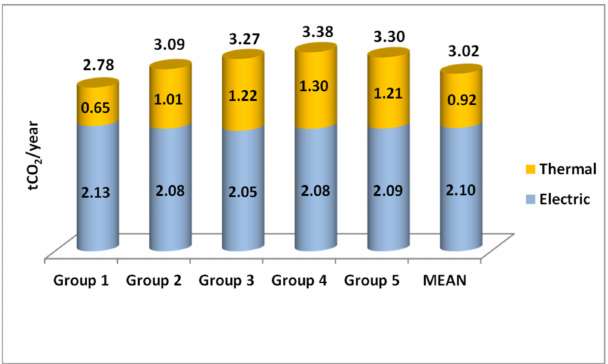
Figure 13. Thermal, electric, and total CO 2 emissions per household by group of